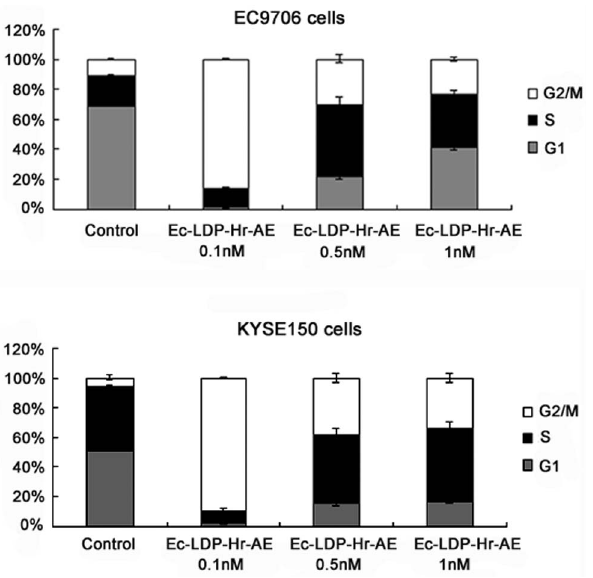
Figure 3. Cell cycle distribution of esophageal cancer cells after treatment with Ec-LDP-Hr-AE. EC9706 cells or KYSE150 cells were exposed to Ec-LDP-Hr-AE for 48 h at the indicated concentrations and cell cycle distribution was determined by flow cytometry after PI staining. Columns, mean of triplicate experiments, bars, SD.